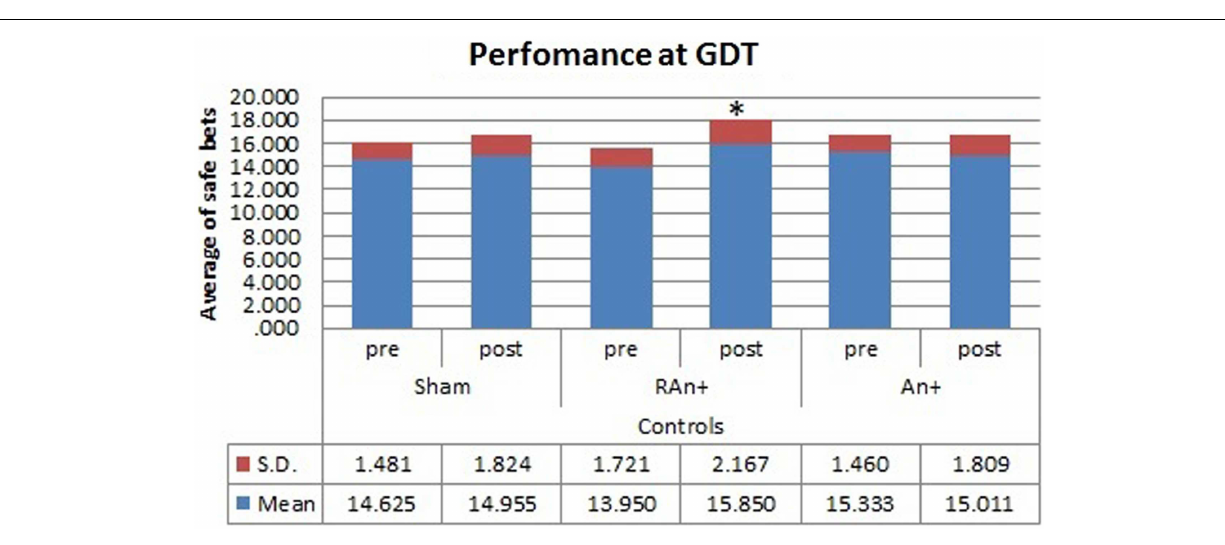
ultimatum game (UG) using repetitive TMS over the